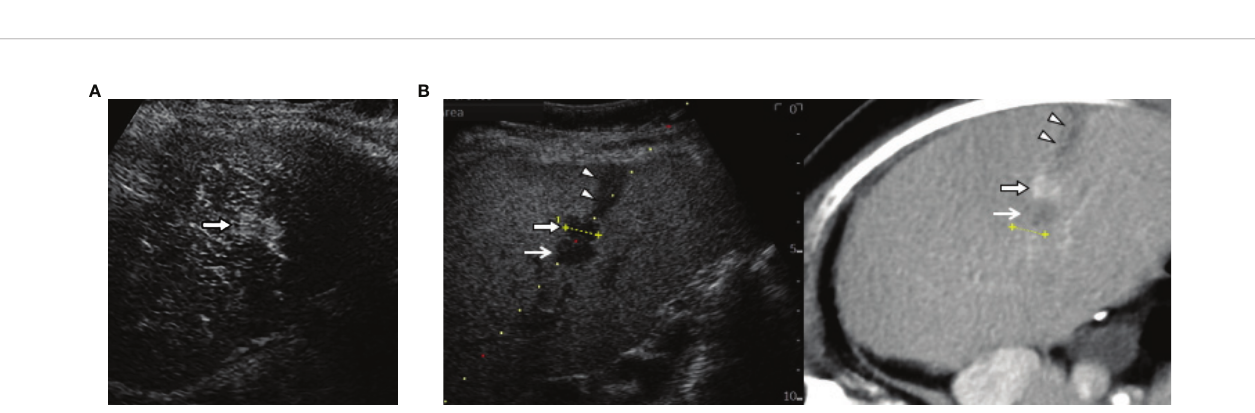
FIGURE 3 | The combination of contrast-enhanced US (CEUS) and fusion imaging. (A) CEUS with Sonazoid shows arterial enhancement of locally progressed hepatocellular carcinoma (HCC) (arrow). (B) The combination of Kupffer image on contrast-enhanced US (CEUS) and fused CT image demonstrates viable HCC (arrow) sandwiched between an ablated tract (arrow heads) and a necrotic tumor (open